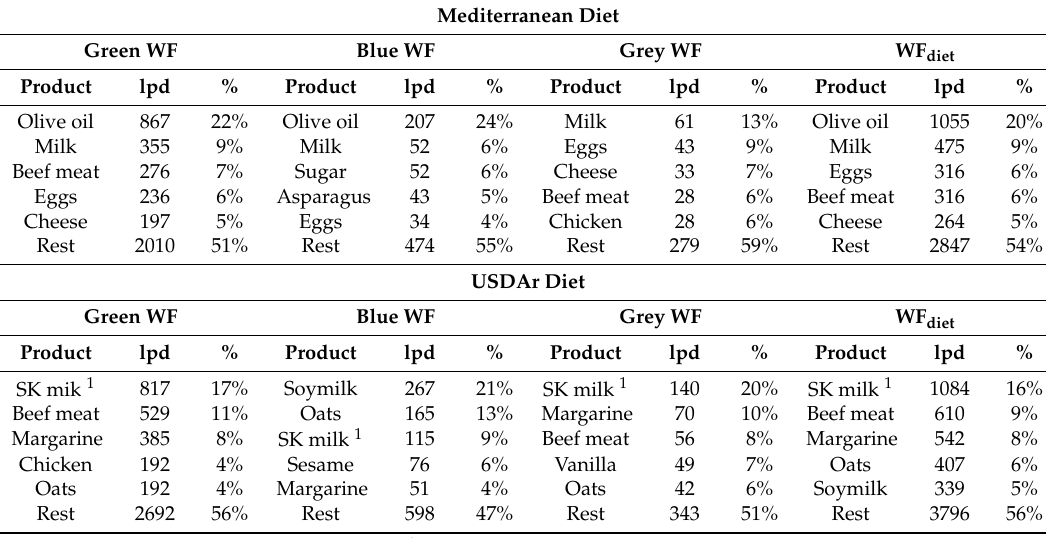
Table 1. The five products that contribute the most in L/person and day (lpd) and % to the green, blue, grey and total WF diet for the Mediterranean and USDAr diets in Spain.